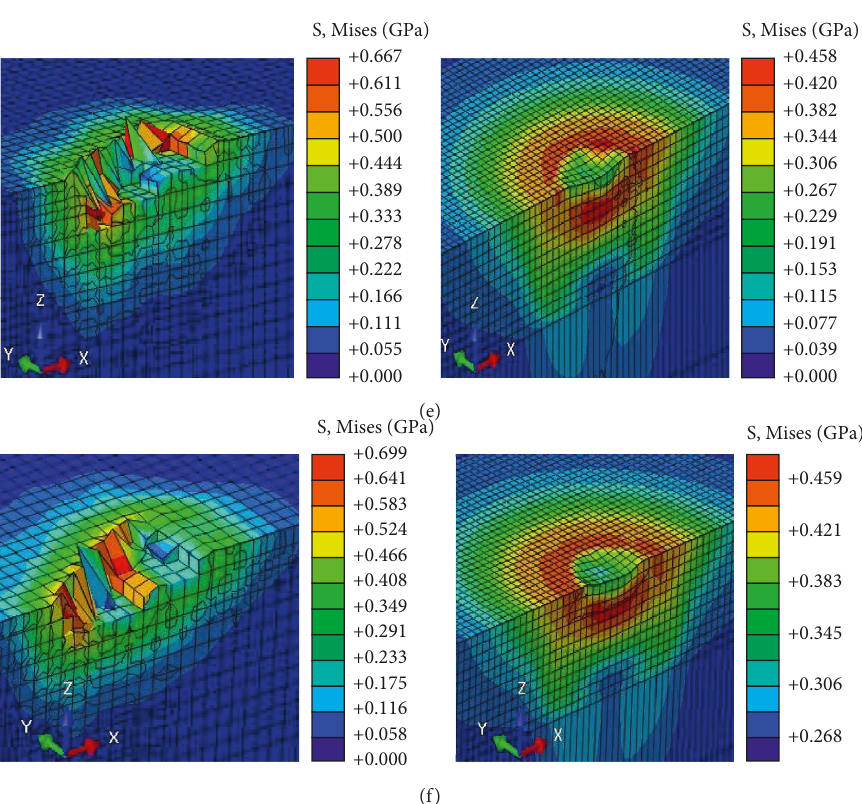
Figure 13: Impact stress contour impacted by multiparticles at different impact angles: (a) 15 ° , (b) 30 ° , (c) 45 ° , (d) 60 ° , (e) 75 ° , and (f) 90 ° (the left figures are of triangular prism shape, and the right figures are of spherical